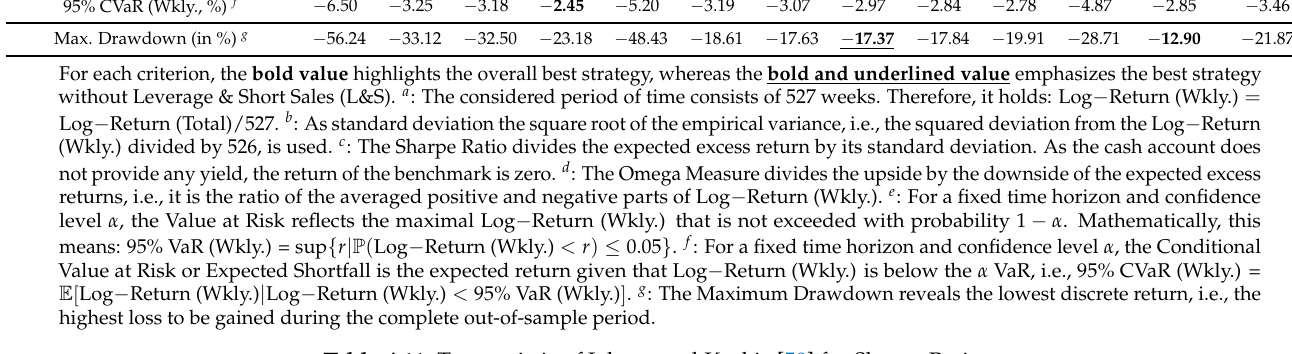
Table A11. Test statistic of Jobson and Korkie [50] for Sharpe